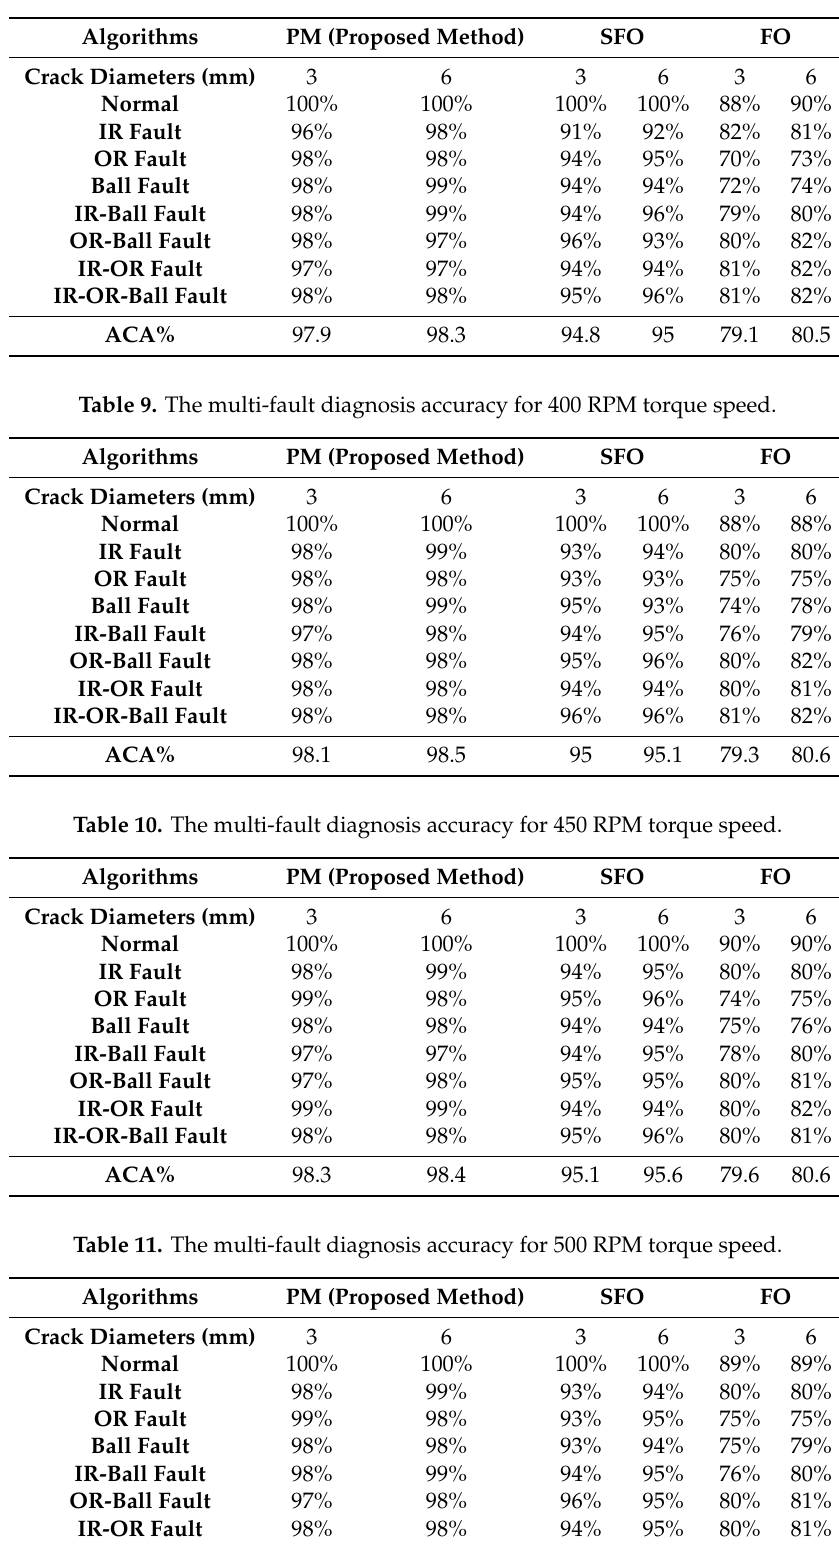
Table 8. The multi-fault diagnosis accuracy for 300 RPM torque speed.